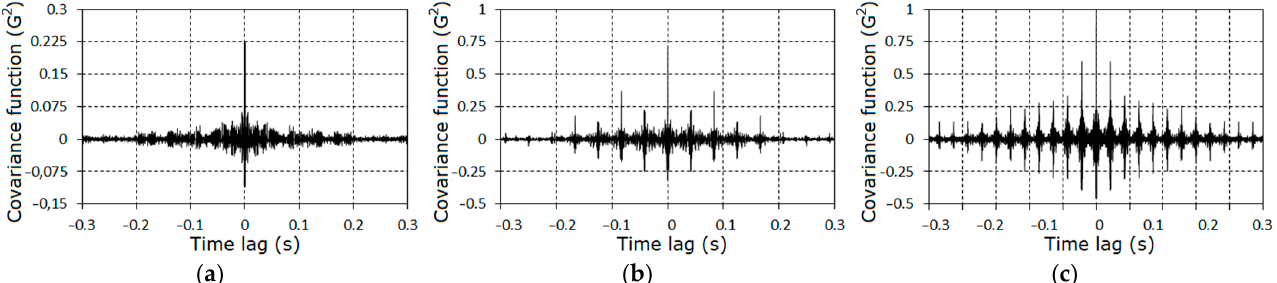
Figure 9. The estimators of the covariance function of the vibration of stochastic parts for the first ( a ), the second ( b ) and the third ( c ) stages.